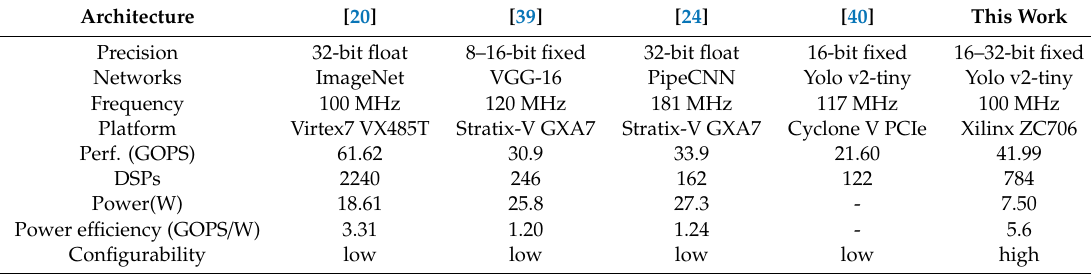
Table 4. Comparison with other